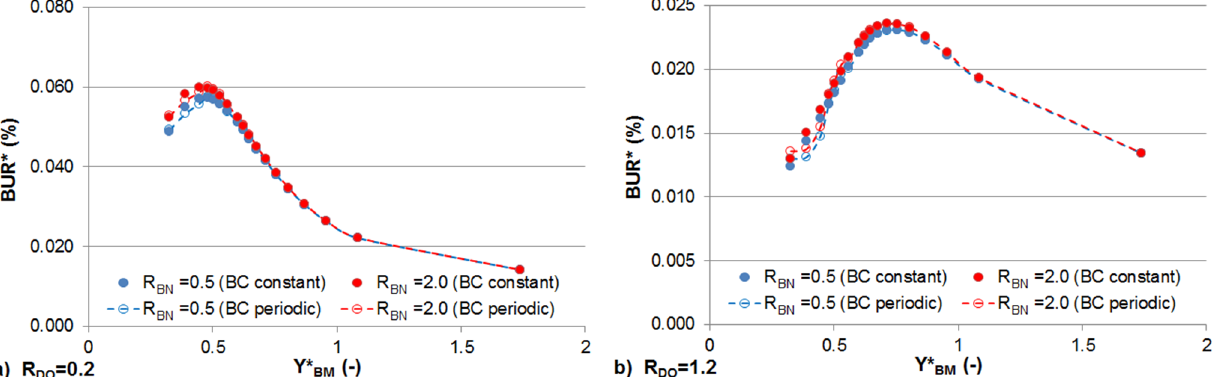
Figure 7. Dimensionless stream BUR , BUR * , as a function of dimensionless mean flow depth, Y * BM , for periodic and constant in-stream boundary conditions and R BN = 0.5 with ( a ) R DO = 0.2 and ( b ) R DO = 1.2, with R DO the ratio between in-stream DO ( DO 0 ) and total oxygen demand ( L 0C + L 0N ) and R BN the ratio between in-stream carbonaceous and nitrogenous BOD concentrations, R BN = L 0C /L 0N